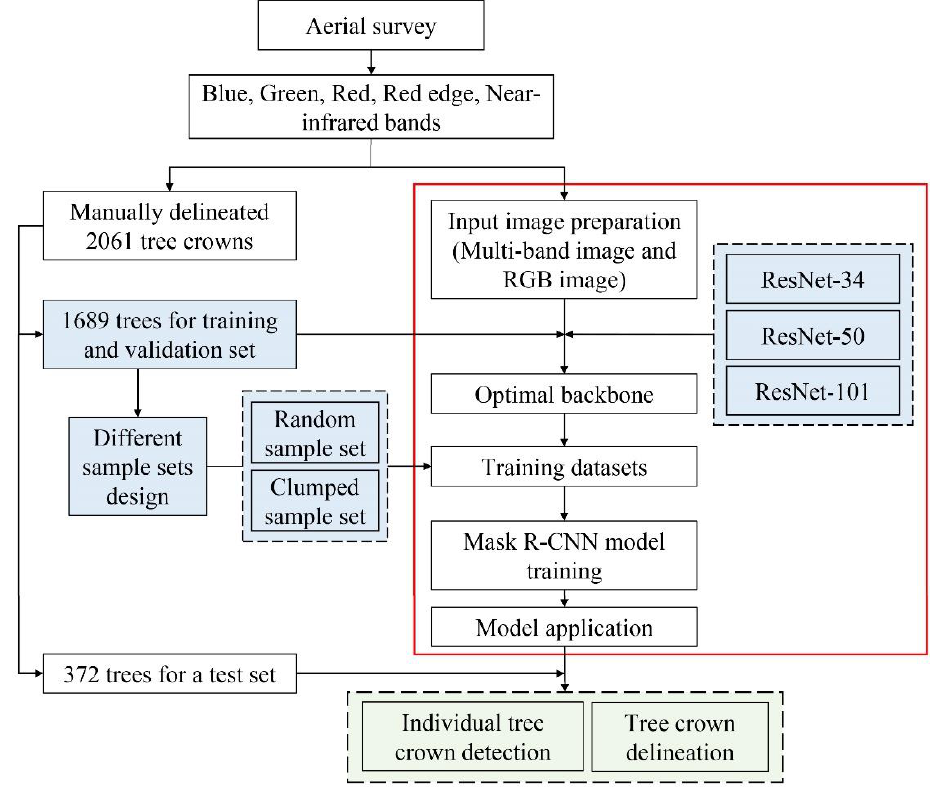
Figure 2. The flowchart of individual tree crown detection and delineation. The light blue color represents the variables; the light green color represents the results from the Mask R-CNN model. The white color objects inside the red box represent the processing steps of Mask R-CNN.